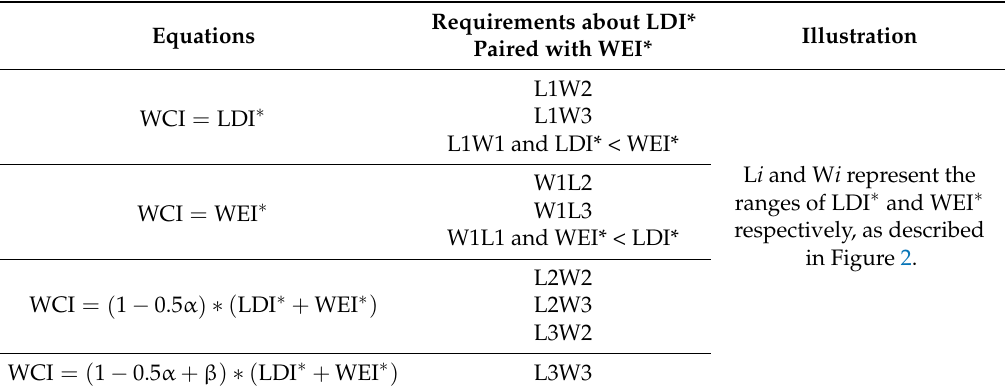
Table 1. The equations of the wetland condition index (WCI) for different conditions. LDI: landscape development intensity index, WEI: water environment